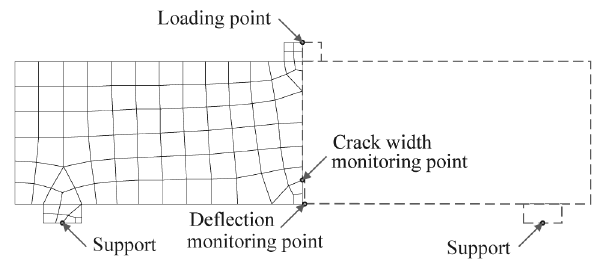
Fig. 8. Model of experimental beam using FE software A TENA